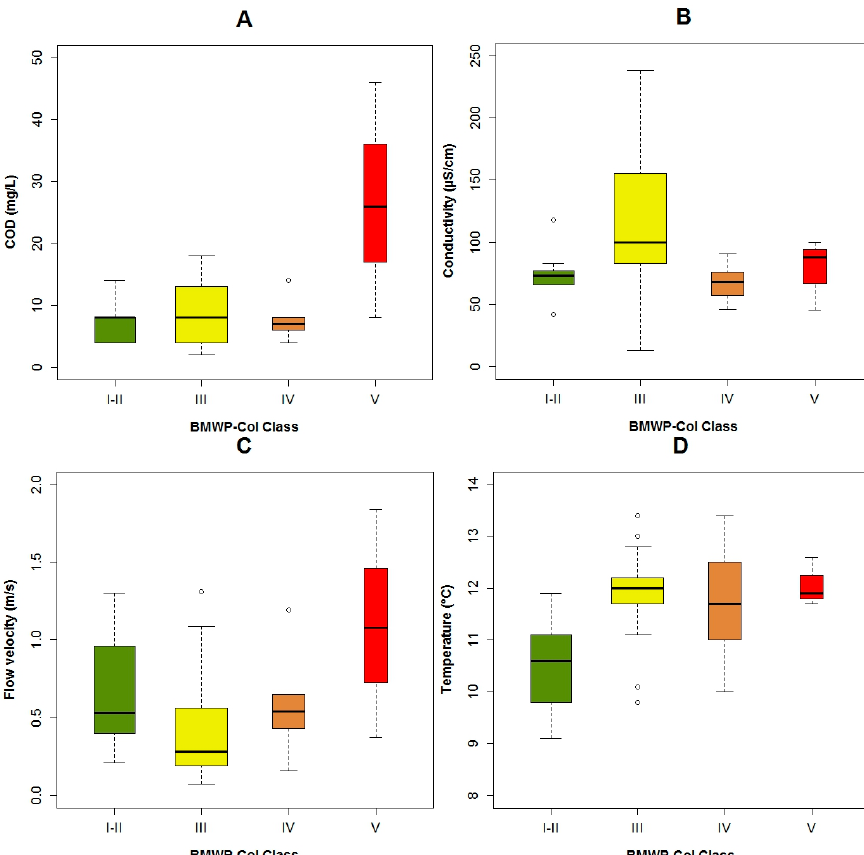
Figure 3. Boxplots of the BMWP-Col class with the main explanatory variables of the three models: ( A ) chemical oxygen demand (COD); ( B ) conductivity; ( C ) flow velocity and ( D ) temperature.